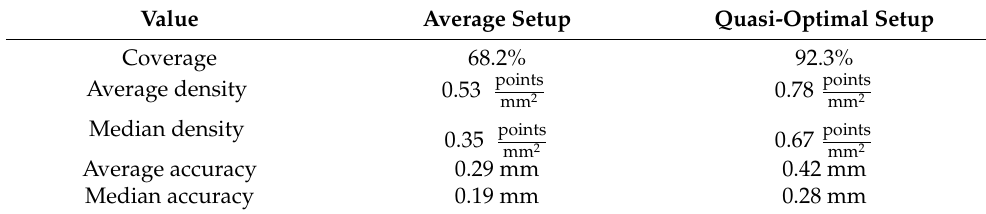
Figure 17. Quasi-optimal 360-degree scene with ( a ) 20-camera distribution and 5 reconstructed spheres within the measurement volume with ( b ) density and ( c ) accuracy evaluations. Values that are higher than 3.0 in ( b ) and 0.5 in ( c ) are marked in black. Table 5. Statistics of coverage, density, and accuracy evaluation for different setups without